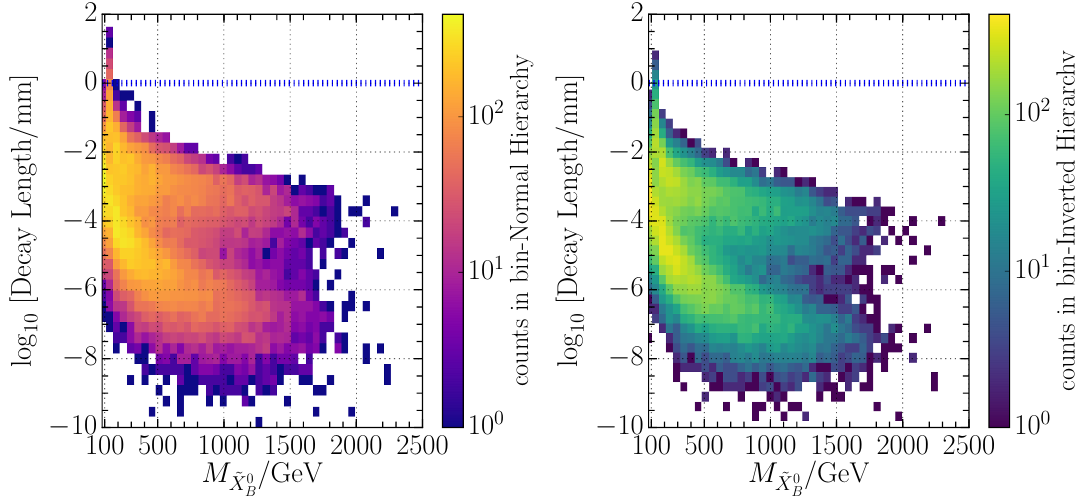
Figure 6. Bino neutralino LSP decay length in millimeters, for the normal and inverted hierarchies, summed over the three decay channels. The average decay length L = c (cid:2) 1 values of M ~ . We have chosen (cid:18) 23 = 0 : 597 for the normal neutrino hierarchy and (cid:18) 23 = 0 : 529 for X 0 B the inverted hierarchy. However, the choice of (cid:18) 23 has no impact on the decay length. The dashed blue line represents the 1 mm decay length, at and below which the decays are \prompt". Note